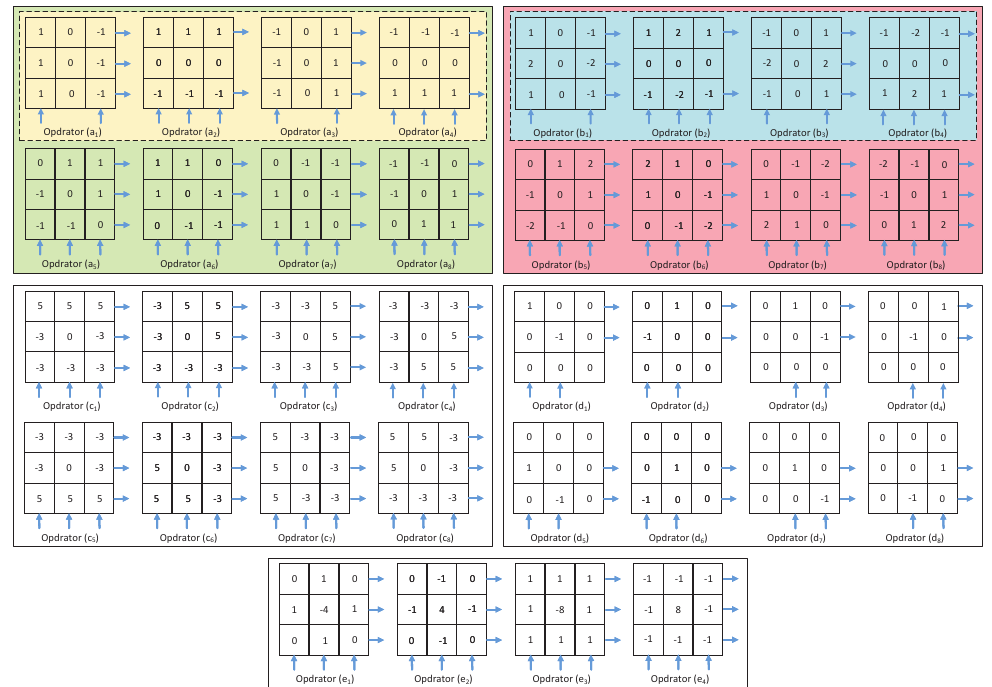
Figure 13. Convolution operator for edge detection. The blue arrow indicates the direction of current, the number sign determines the polarity of the voltage. ( a 1 –a 4 ) Prewitt operator (in the yellow box). ( a 1 –a 8 ) Proposed Prewitt operator (in the green box). ( b 1 –b 4 ) Sobel operator (in the blue box). ( b 1 –b 8 ) Proposed Sobel operator (in the red box). ( c 1 –c 8 ) Kirsch operator. ( d 1 –d 8 ) Robert operator. ( e 1 –e 4 ) Laplacian operator.